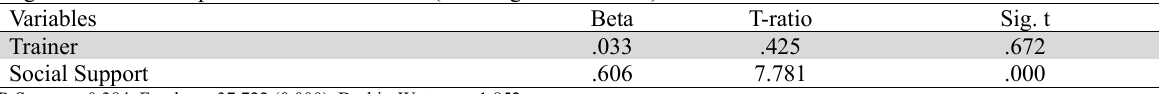
Regression results dependent variable: Result (Training effectiveness)